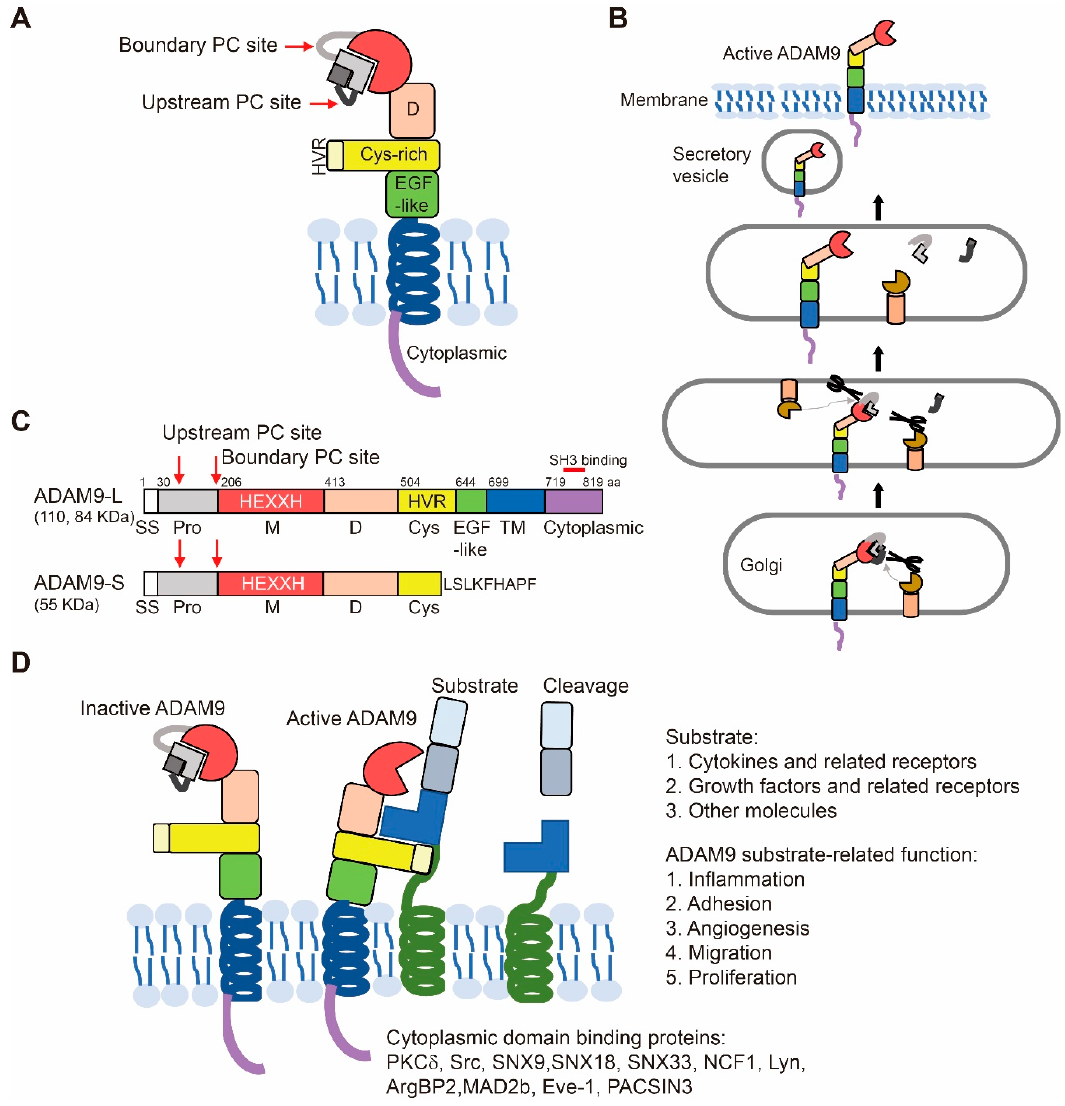
Figure 1. Characterization of a disintegrin and metalloprotease 9 (ADAM 9). ( A ) The organization of the C-shape structure when anchored to the membrane is shown. ( B ) ADAM9 is activated during transport via Golgi bodies to the cell membrane by removal of the inhibitory pro-domain. The pro-domain cleavage is performed at the two PC sites by furin or proprotein convertase. ( C ) Schematic diagrams of the domain structure of the long (ADAM9-L, 110 and 84 KDa) and short (ADAM9-S, 55 KDa) forms of ADAM9. ADAM9-S lacks exon 12 from the ADAM9-L genetic sequence. aa, amino